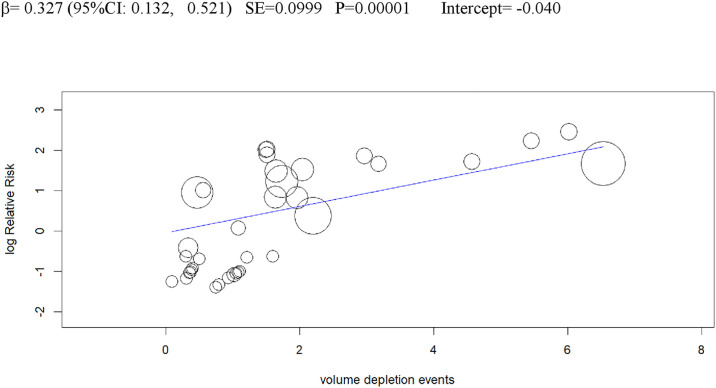
Univariable meta-regression plots for statistically significant moderators of the RR of DKA: Volume depletion events.DKA, diabetic ketoacidosis; RR, risk ratio.